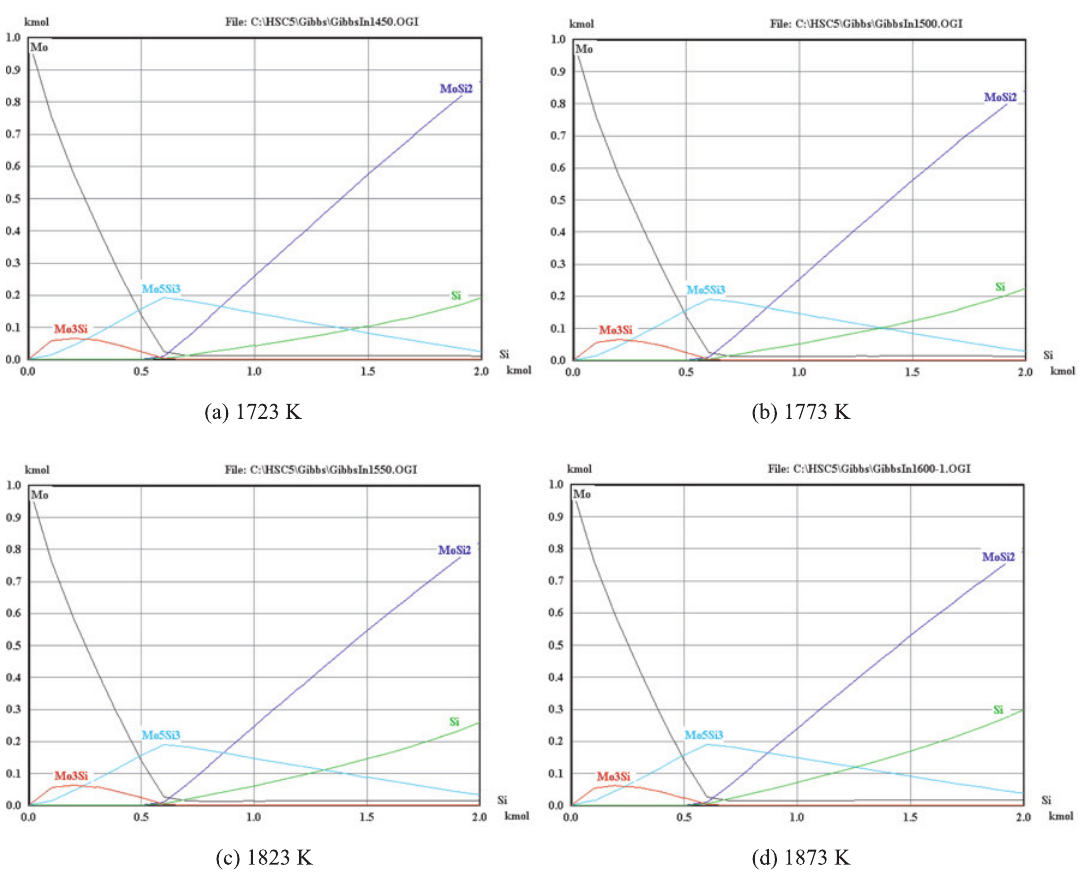
Fig. 8: Effects of temperature on the equilibrium phase diagram of the Si-Mo system (Si/Mo =